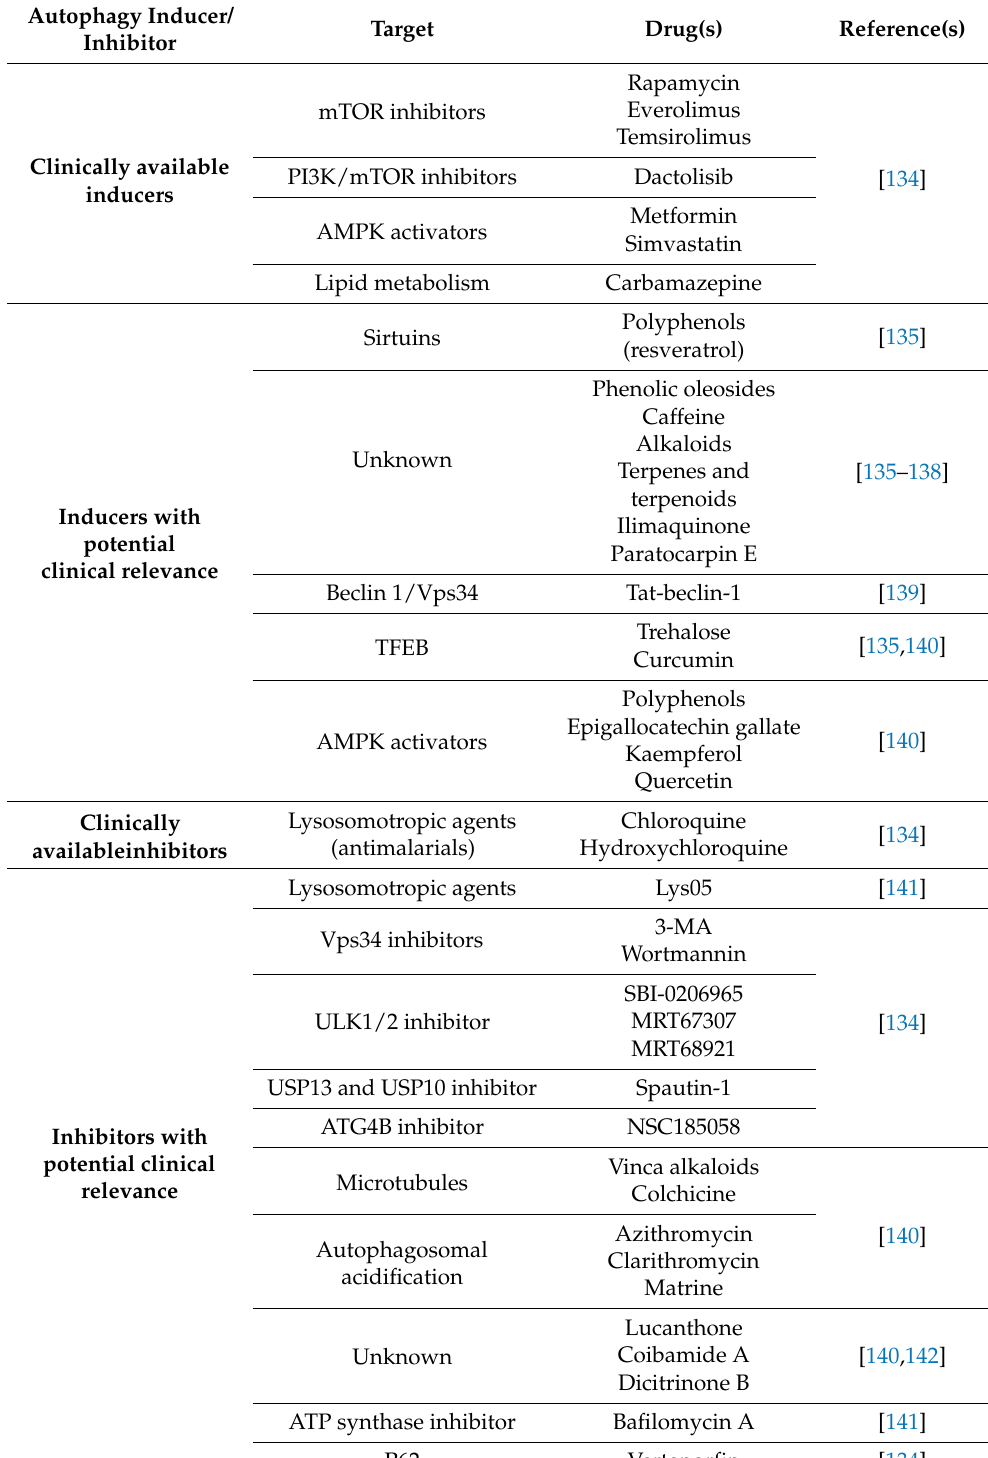
Table 1. Pharmacological and natural products known to modulate